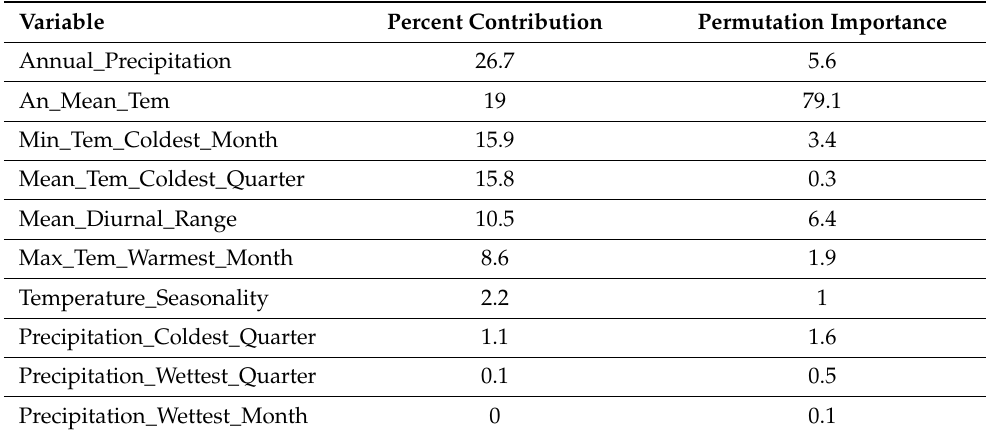
Table 2. Average contribution (out of 5000 iterations) of environmental variables to the prediction of the global distribution of Psa using MaxEnt.